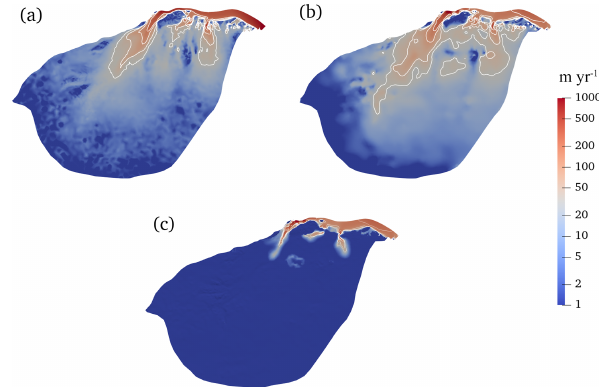
Figure 6. (a) Observed surface velocity, (b) modelled surface ve- locity in the experiment, using the Martos et al. (2017) GHF, and (c) modelled basal velocity. The white solid lines in panels (a) , (b) , and (c) represent speed contours of 30, 50, 100, and 200myr − 1 , respectively. The three fast-flowing outlet glaciers in panel (a) from left to right are the Lambert, Lepekhin, and Kronshtadtskiy